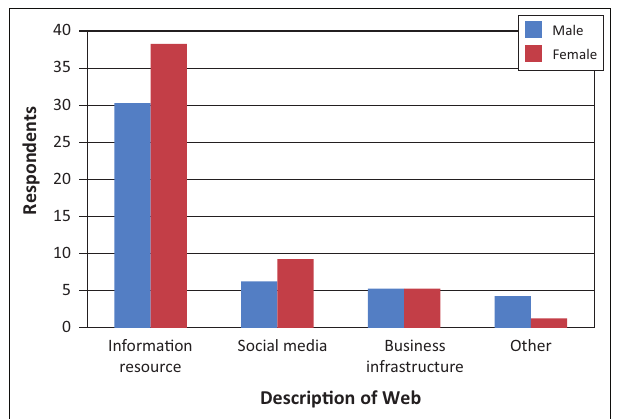
FIGURE 5: Cross-tabulation between gender and view of the Web.